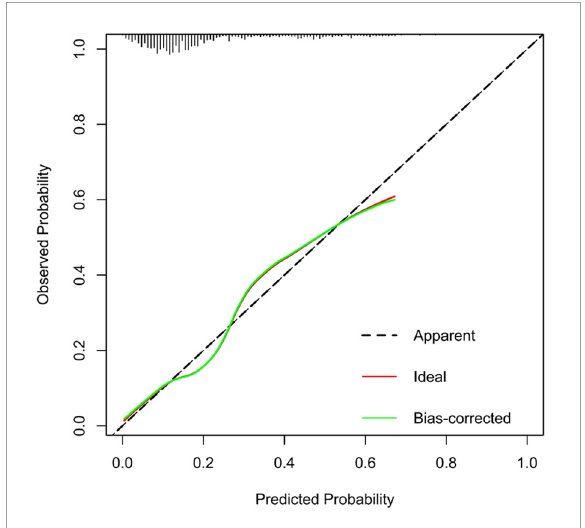
FIGURE4 Calibration curves of the depression incidence risk nomogram prediction in training set.